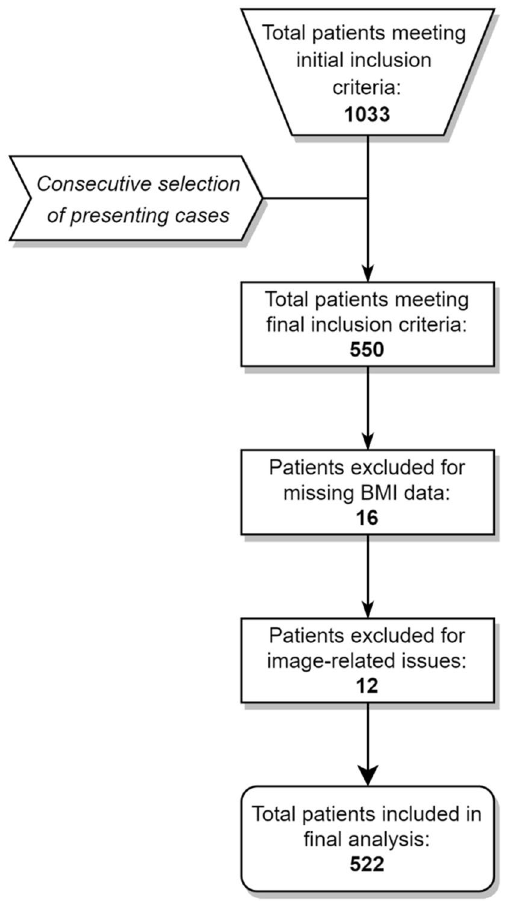
Figure 3. Pathology case selection flowchart.